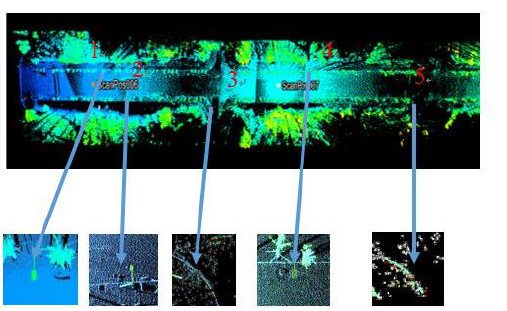
Figure 11. Ground-based LiDAR Feature Points